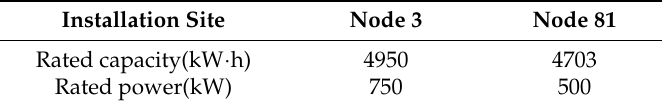
Table 2. Configuration results of the second-stage